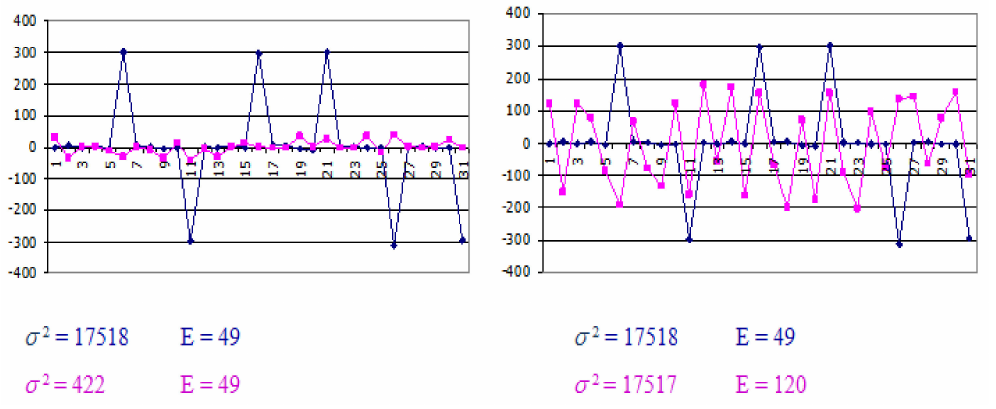
Figure 5. Variance vs. energy entropy values for exemplary